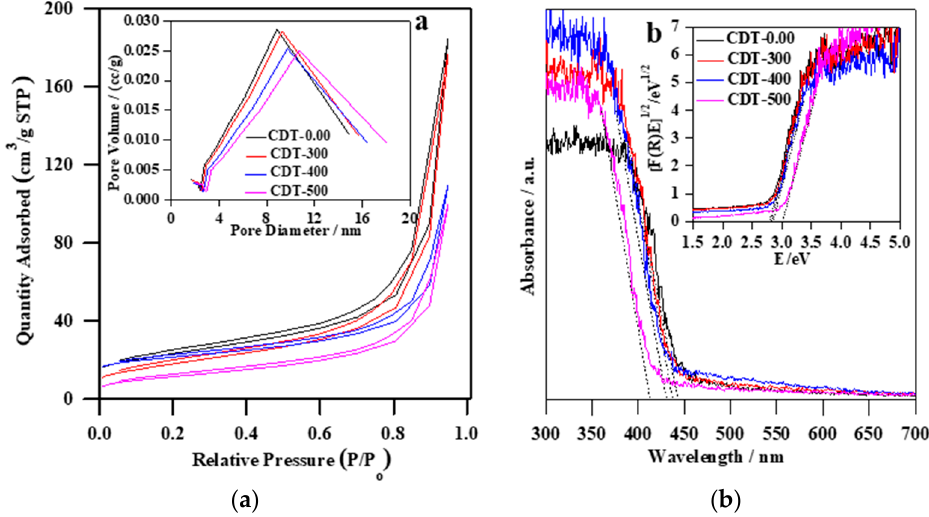
Figure 4. ( a ) N 2 sorption isotherm and pore size distribution (inset); and ( b ) diffuse reflectance spectra and Tauc plots (inset) for all obtained samples. Materials 2019 , 12 , x FOR PEER REVIEW Table 3. The surface composition of Ti, O, C, and N obtained from XPS.